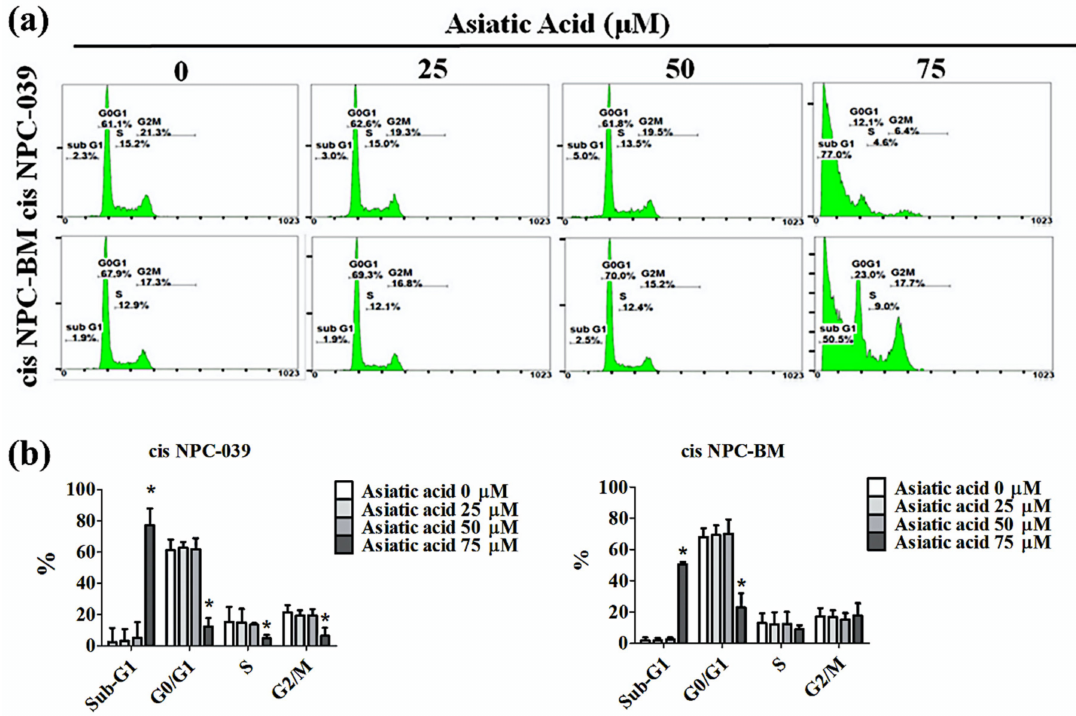
Figure 2. Asiatic acid cause cell cycle arrest in cis NPC-039 and cis NPC-BM cell lines. ( a ) The cisplatin- resistant human NPC cell lines were treated with Asiatic acid (0, 25, 50, and 75 µ M). Cell cycle phase distribution (Sub-G1, G0 / G1, S, and G2 / M) were estimated by flow cytometry. ( b ) The rate of different phase of cell cycle in cis NPC-039 and cis NPC-BM cell lines. * p < 0.05 as compared with control